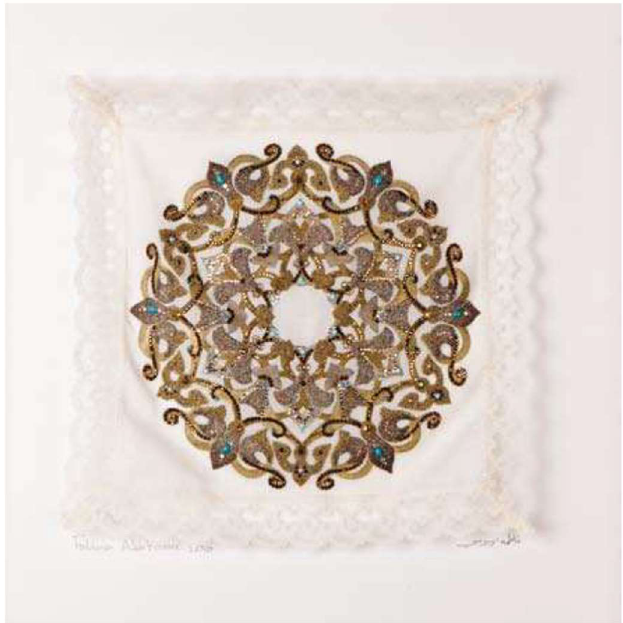
Figure 11. Fatima Abu Rumi, From the Bridal Kerchiefs series, 2009–2010, kerchief, acrylic and zircons 23 × 23 cm, Hisham and Rawia Abu Hanna Collection.